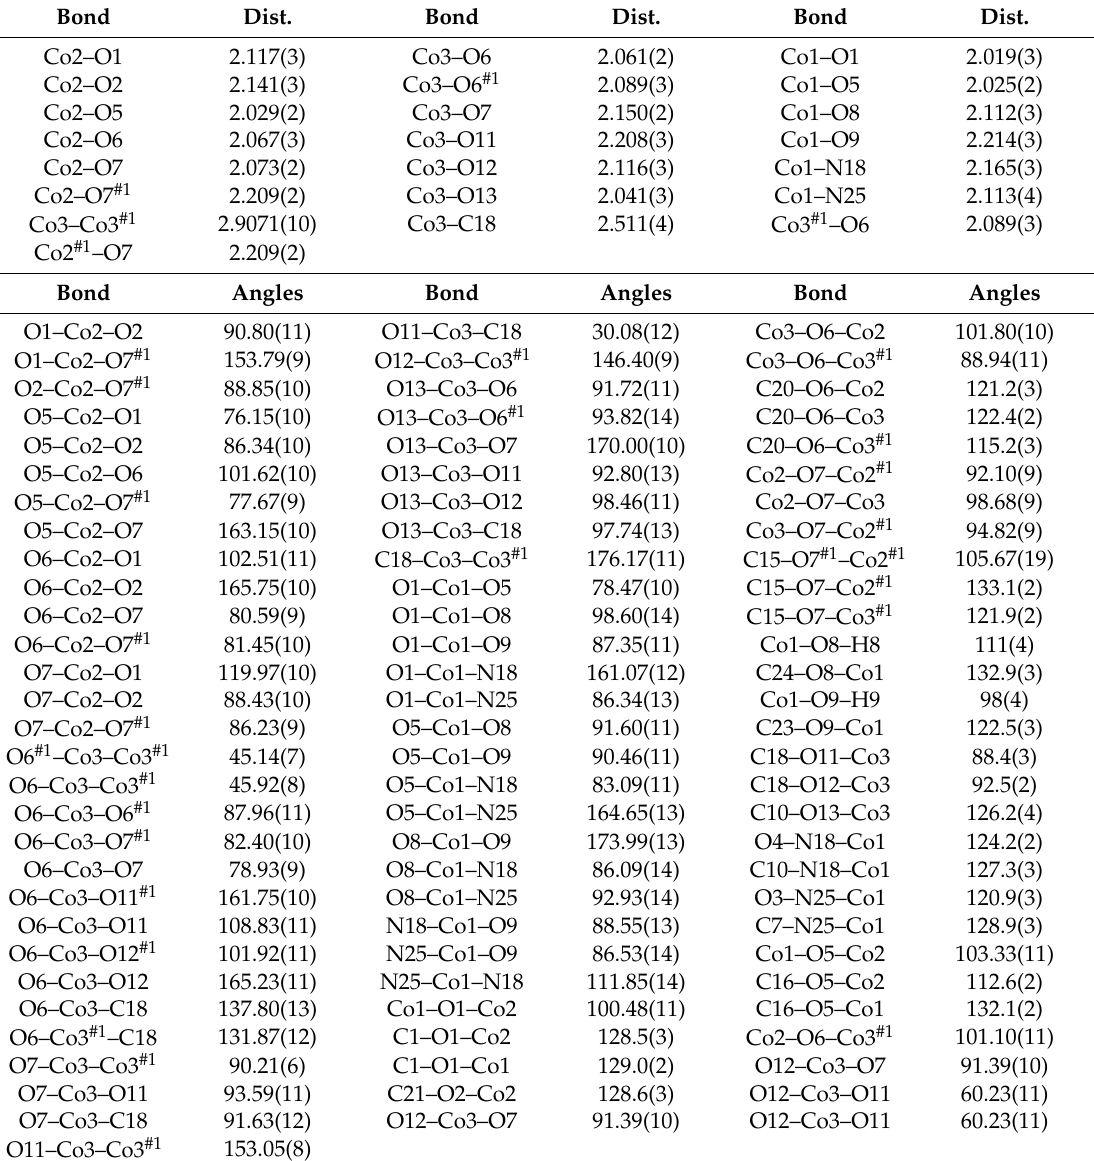
Table 2. Selected bond lengths (Å) and angles ( ◦ ) for the Co(II) coordination compound. Bond Dist. Bond Dist. Bond